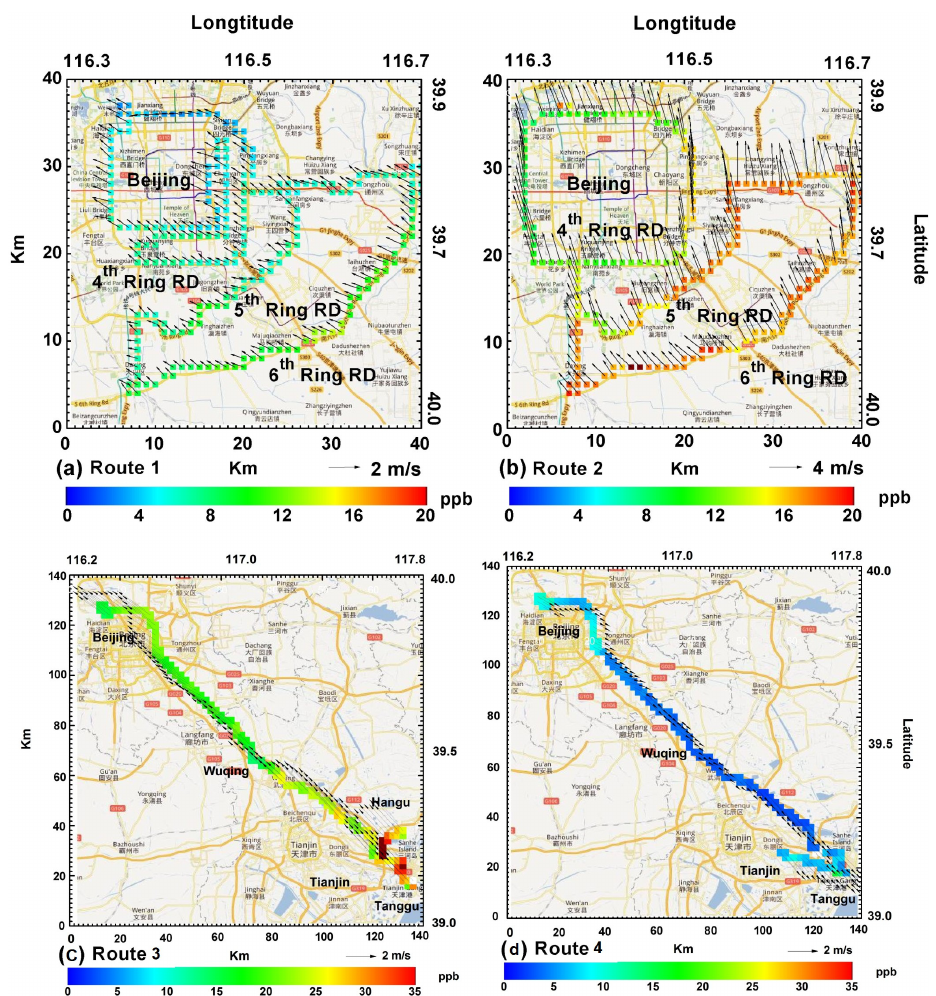
Fig. 5. The spatial distributions of SO 2 concentrations and wind field by WRF with 1 × 1km grids resolution in southeastern areas of Beijing on (a) 20 August and (b) 4 September 2008, and 2 × 2km grids from Beijing to Tianjin on (c) 3 September and (d) 11 September